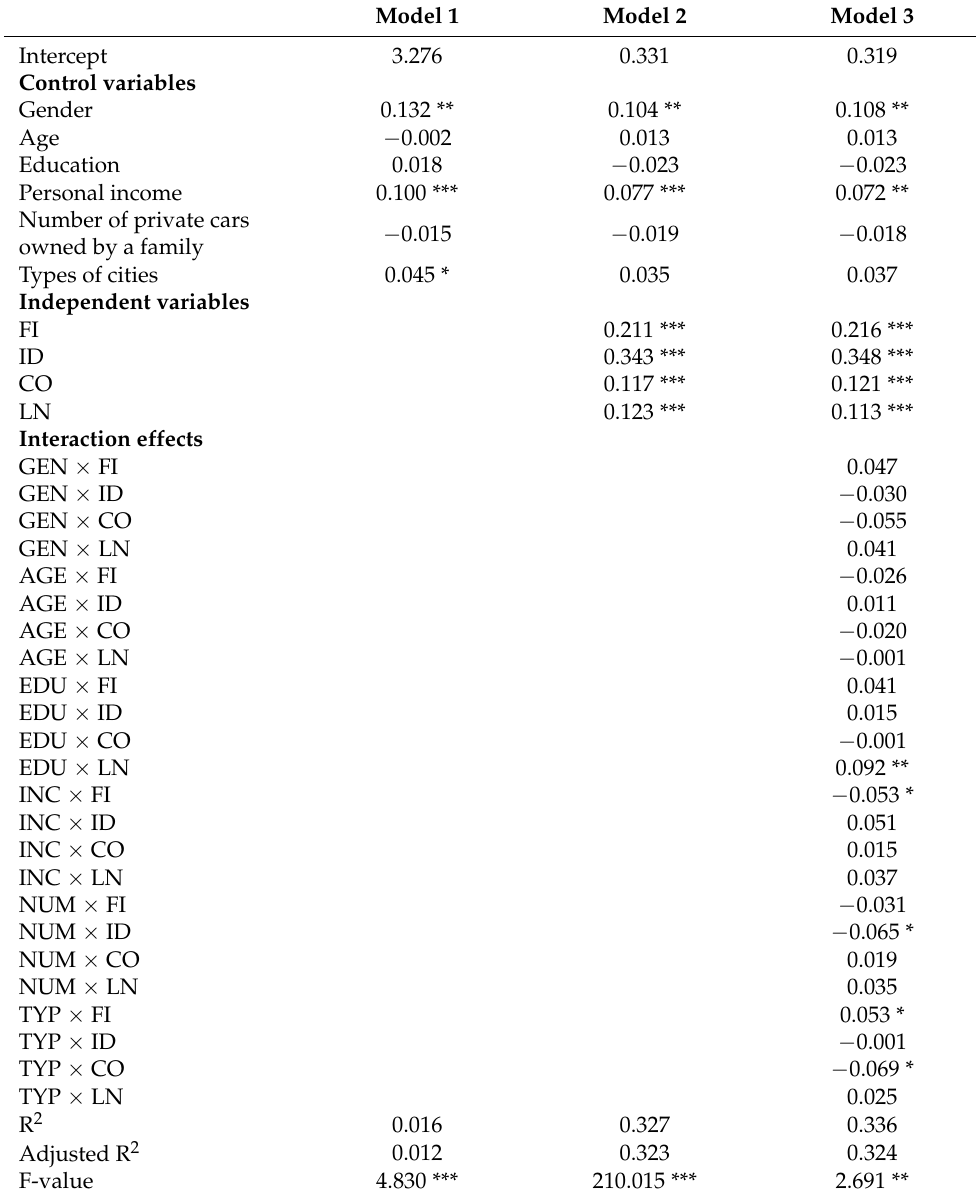
Table 5. Impacts of policy measures and moderating effects of demographic